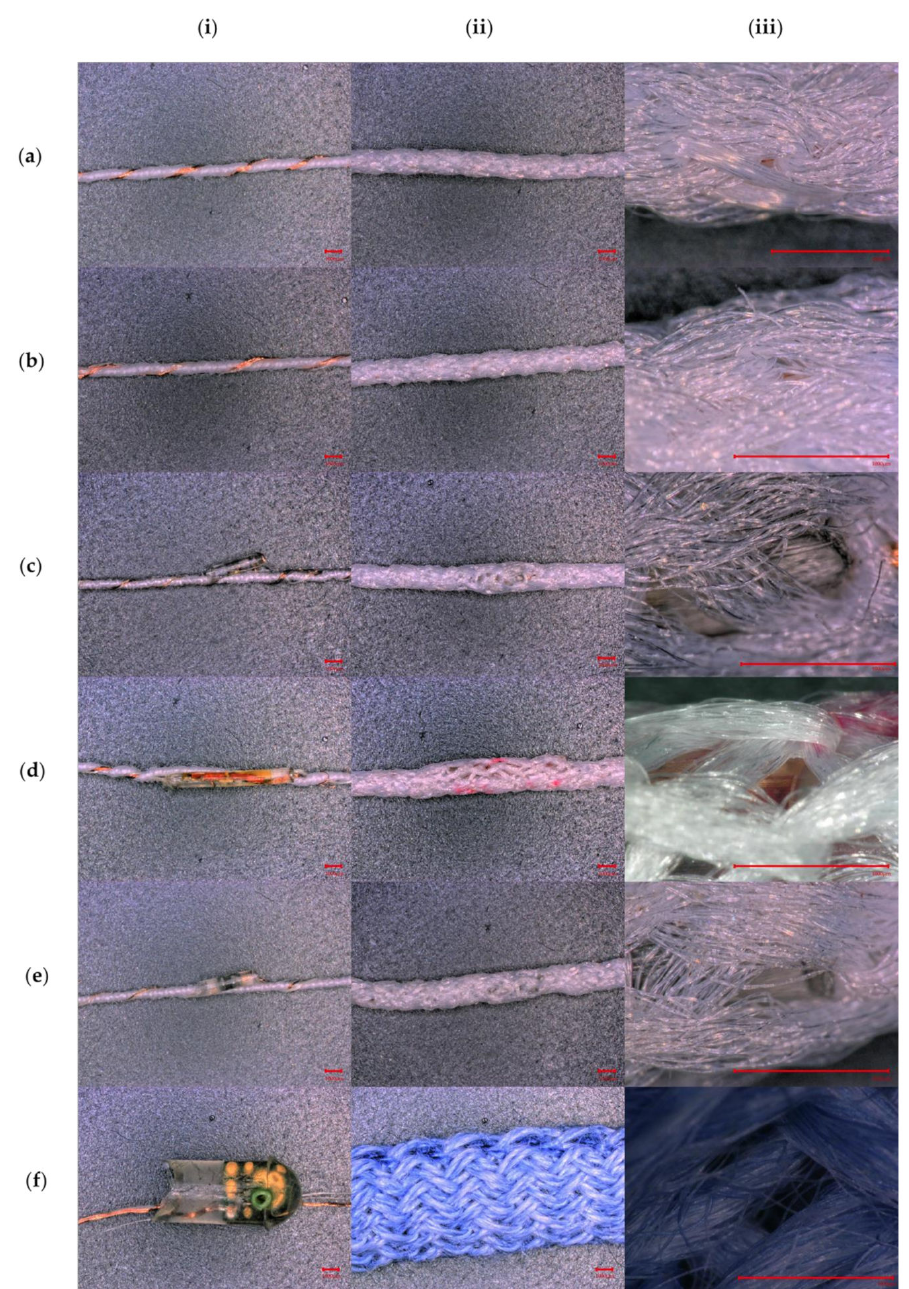
Figure 1. Microscope images of the E-yarns used in this work ( i ) before covering with a knit braid ( ii ) final yarn. ( iii ) High magnification image of the knit braid, showing coverage. ( a ) Conductive wire E-yarn. ( b ) Conductive wire E-yarn with a supporting yarn. ( c ) Illuminated E-yarns containing LEDs. ( d ) LEDs mounted on polyimide strip circuits embedded within the E-yarns. ( e ) Temperature sensing E-yarn. ( f ) Acoustic sensing E-yarns. Scale bar shows 1